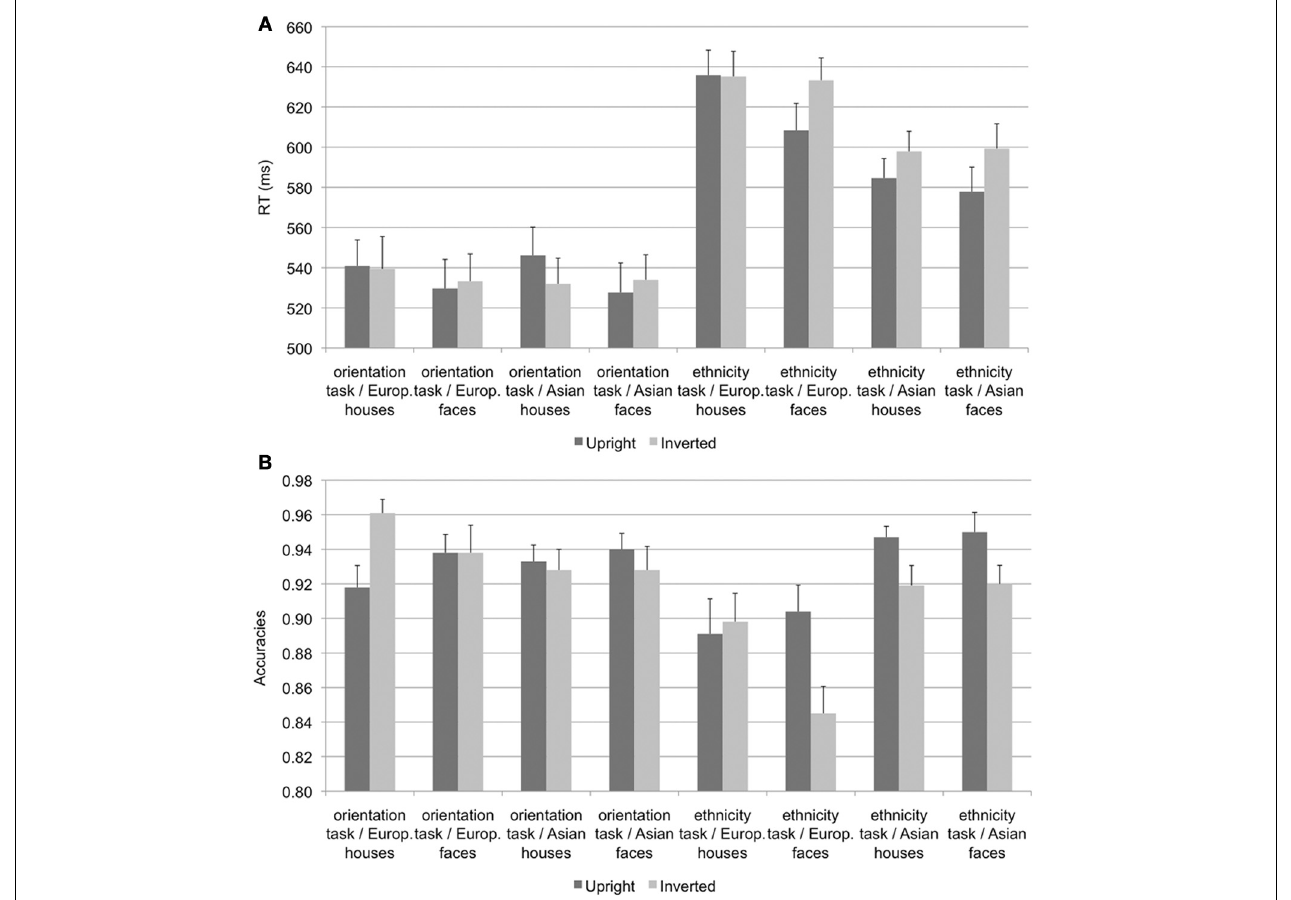
FIGURE 1 | Mean reaction times (A) and accuracies (B), error bars denote standard errors of the mean.